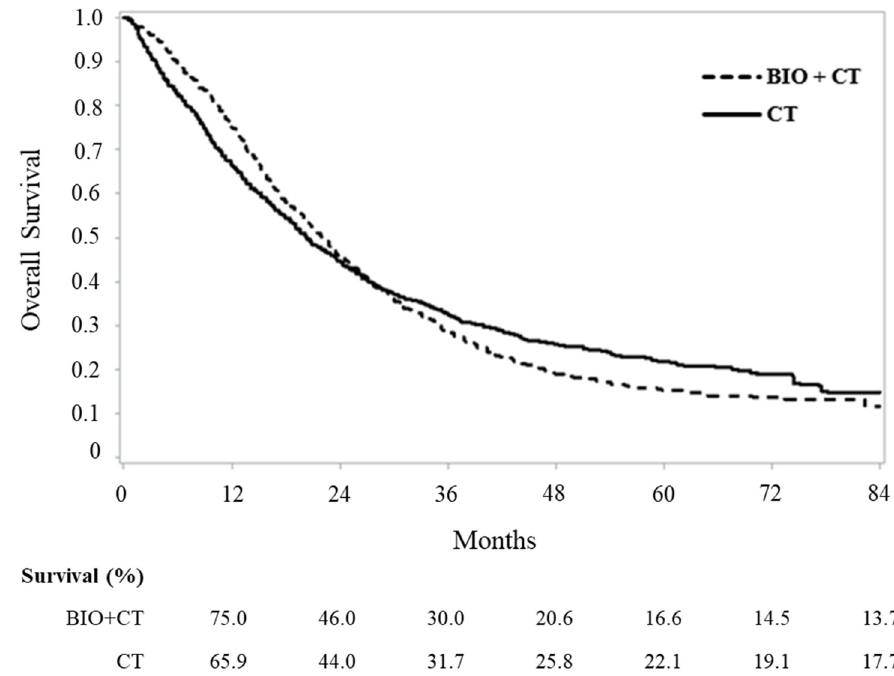
Figure 2. Comparison between Kaplan–Meier overall survival curves of metastatic colorectal cancer cohort members on first-line treatment with biologic-based (bevacizumab or cetuximab, Bio + CT) or standard chemotherapy (CT) alone. FABIO project, Italy, 2010–2016.